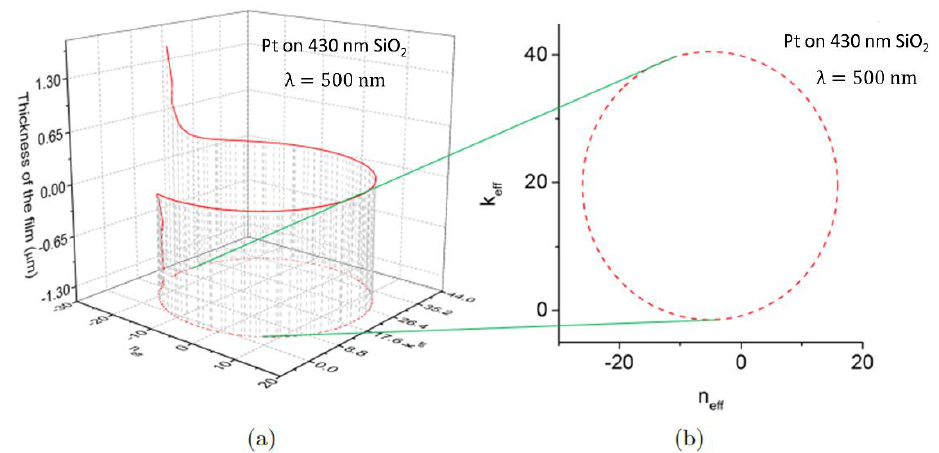
Figure 3. ( a ) The helical dependence of the metal nano-film thickness, d 1 on the trilayer optical constant, N e ff = n e ff + i k e ff in the ( d 1 , n e ff , k e ff ) space. The film thickness d 1 is calculated using Equation (4). By changing the nano-film thickness the optical constant N e ff will follow the helical trajectory shown in red. This illustrates that the optical constant of the film is largely determined by the film thickness. ( b ) The projection of d 1 on the ( n e ff , k e ff ) plane is a circle. The trajectory has been calculated for ultra-thin Pt film, which N 1 = 3.20 − 4.3 i , deposited on 430 nm of SiO 2 on Si.